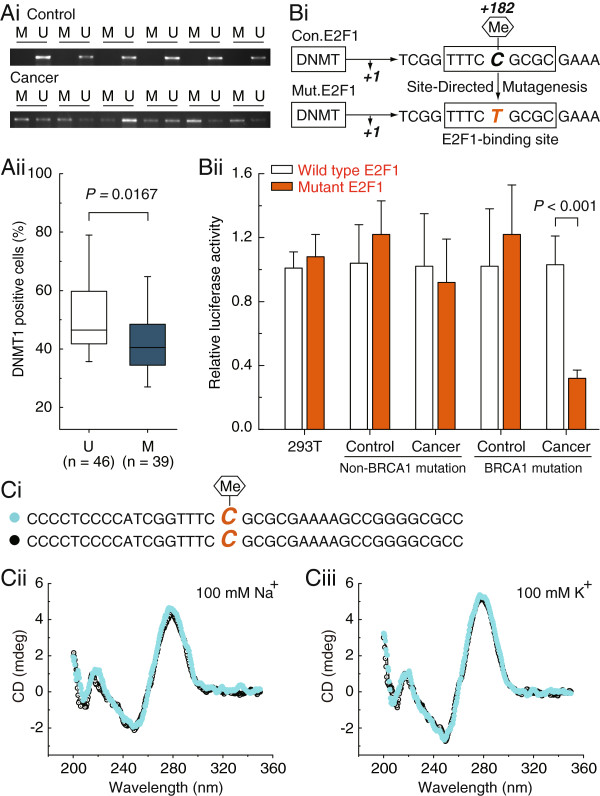
Repression of DNMT1 promoter activity by methylated E2F1 motif. Ai, comparative analysis of E2F1 motif methylation between BRCA1-mutated breast cancer and adjacent normal breast tissues. Aii, relationship between DNMT1 protein expression and promoter methylation in BRCA1-mutated breast cancer and adjacent normal breast tissues (U; unmethylated group, n = 46, M; methylated group, n = 39). Bi, the schematic shows that the nucleotide sequence of consensus E2F1 motif (Con.E2F1) was point mutated at position +182 (C to T) to generate the Mut.E2F1. Bii, 293 T cells, and 15 primary non-mutated and BRCA1-mutated breast cancer and their normal breast cells were transfected with Con.E2F1 and Mut.E2F1. 24 hours after transfection, whole-cell extracts were analyzed for luciferase activity. Each experiment was repeated four times for 293 T cells and primary breast cells of each patient. Bar graphs show mean ± SD. Ci, the schematic represents the selected nucleotide sequence containing the E2F1 motif, with or without a methyl group at the fifth position of the cytosine pyrimidine ring at position +182. Cii and Ciii, The CD spectra of the selected nucleotide sequence in the presence of 100 mM Na+ or 100 mM K+ are shown.